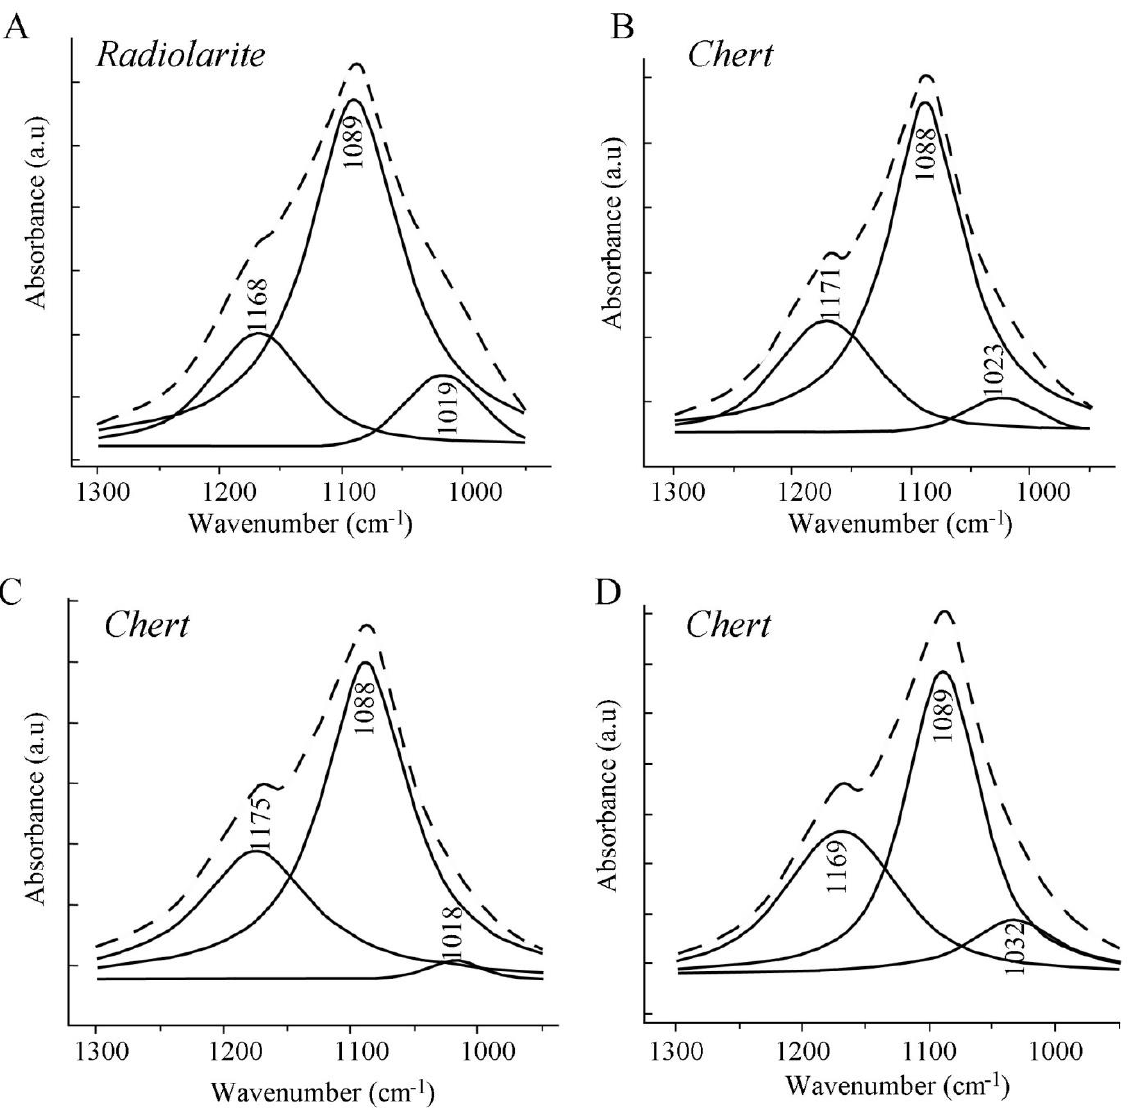
Figure 6. Experimental and deconvoluted spectra in the 1300-950 cm -1 range for (A) Radiolarite; sample 4379; (B, C, and D) Chert; samples 4419, 4622(2), and 4350(2). The experimental spectrum is drawn with a dashed